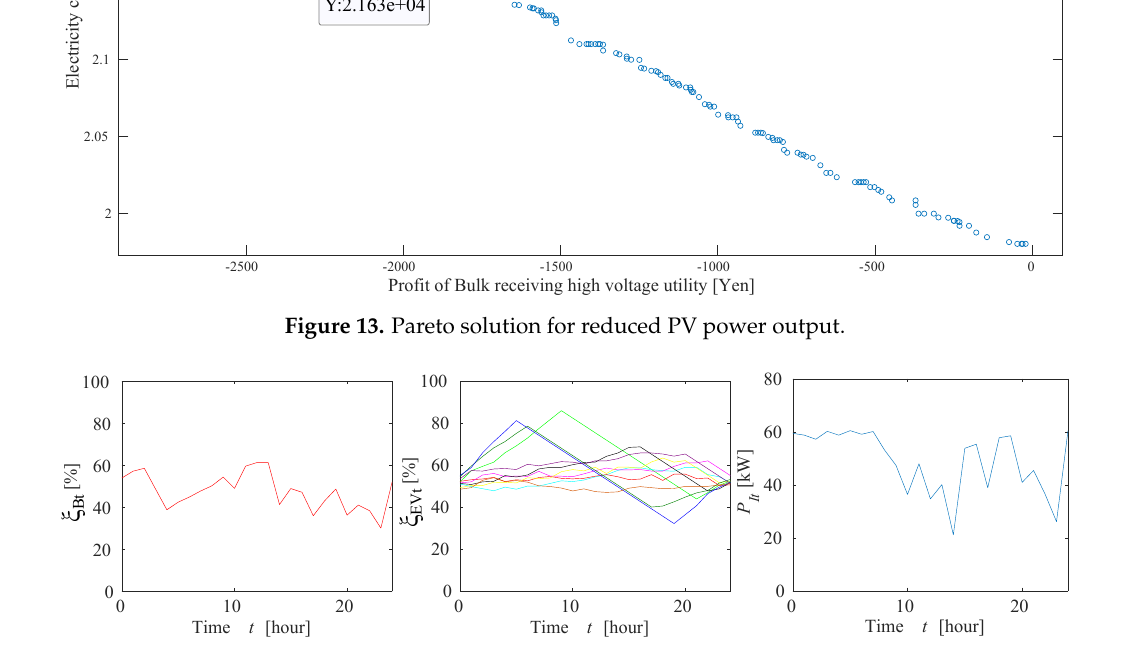
Figure 14. Simulation results with (B): ( a ) SOC of fixed battery; ( b ) SOC of EVs and ( c ) power